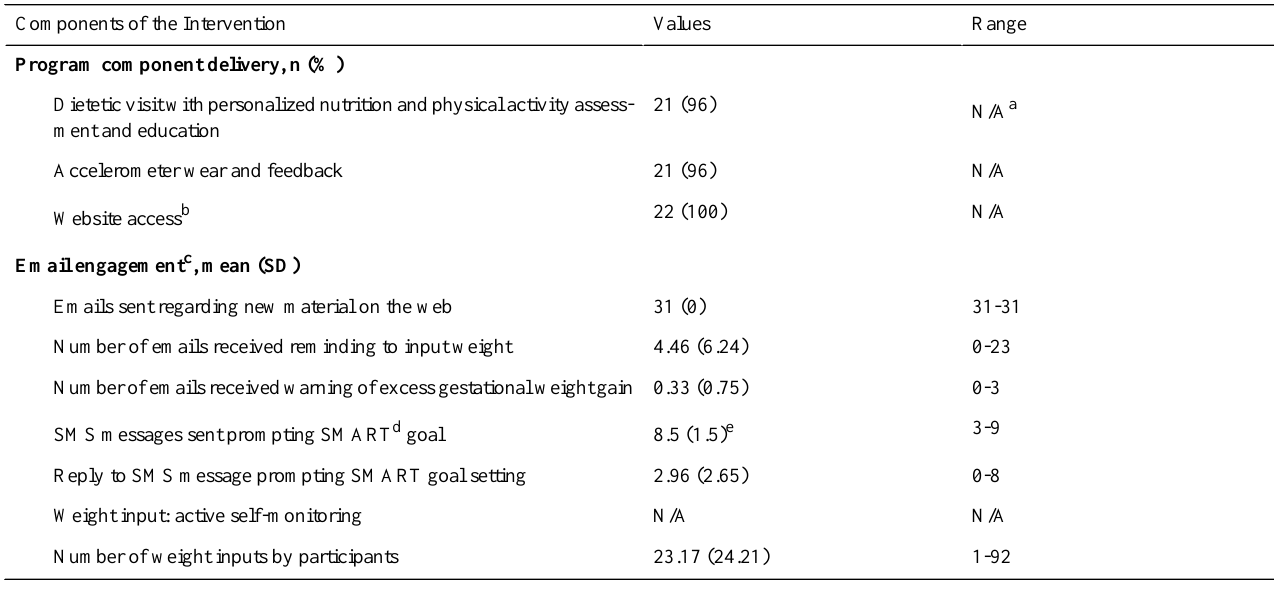
Table 2. Intervention interaction data